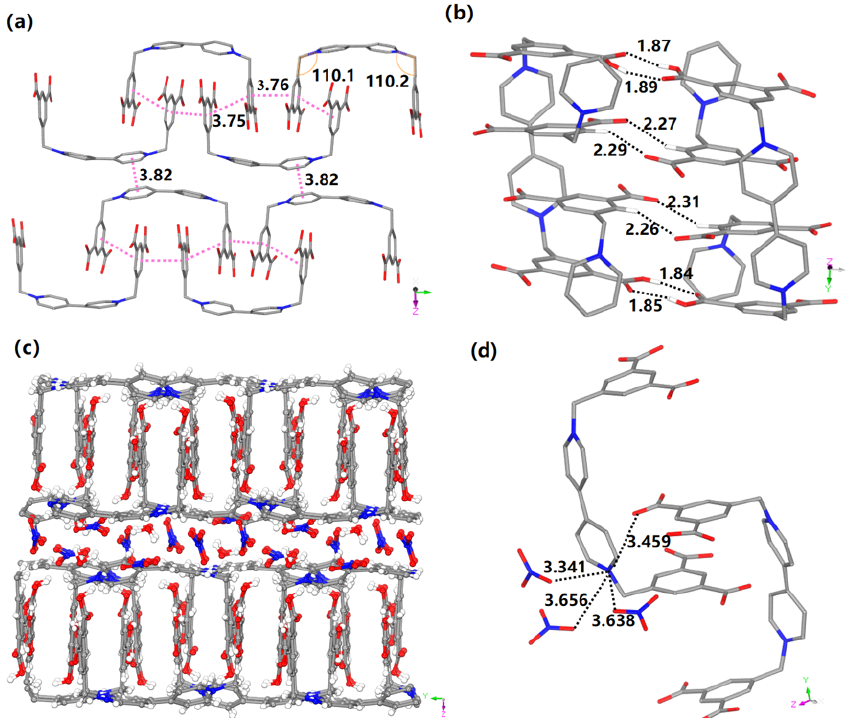
Figure 1. ( a ) The conformation of H 4 bdcbpy and the supramolecular layer formed by π – π type interactions (highlighted by the pink dotted lines). ( b ) The hydrogen bond interactions between the adjacent layers along a direction. ( c ) The free H 2 O and nitrate ions between the layers. ( d ) The O···N distance between adjacent carboxylate O atom, nitrate O atoms and bipyridinium N atom (Color modes: C—gray, N—blue, O—red and H—white. For clarity, some hydrogen atoms in ( a , b , d ) were omitted).